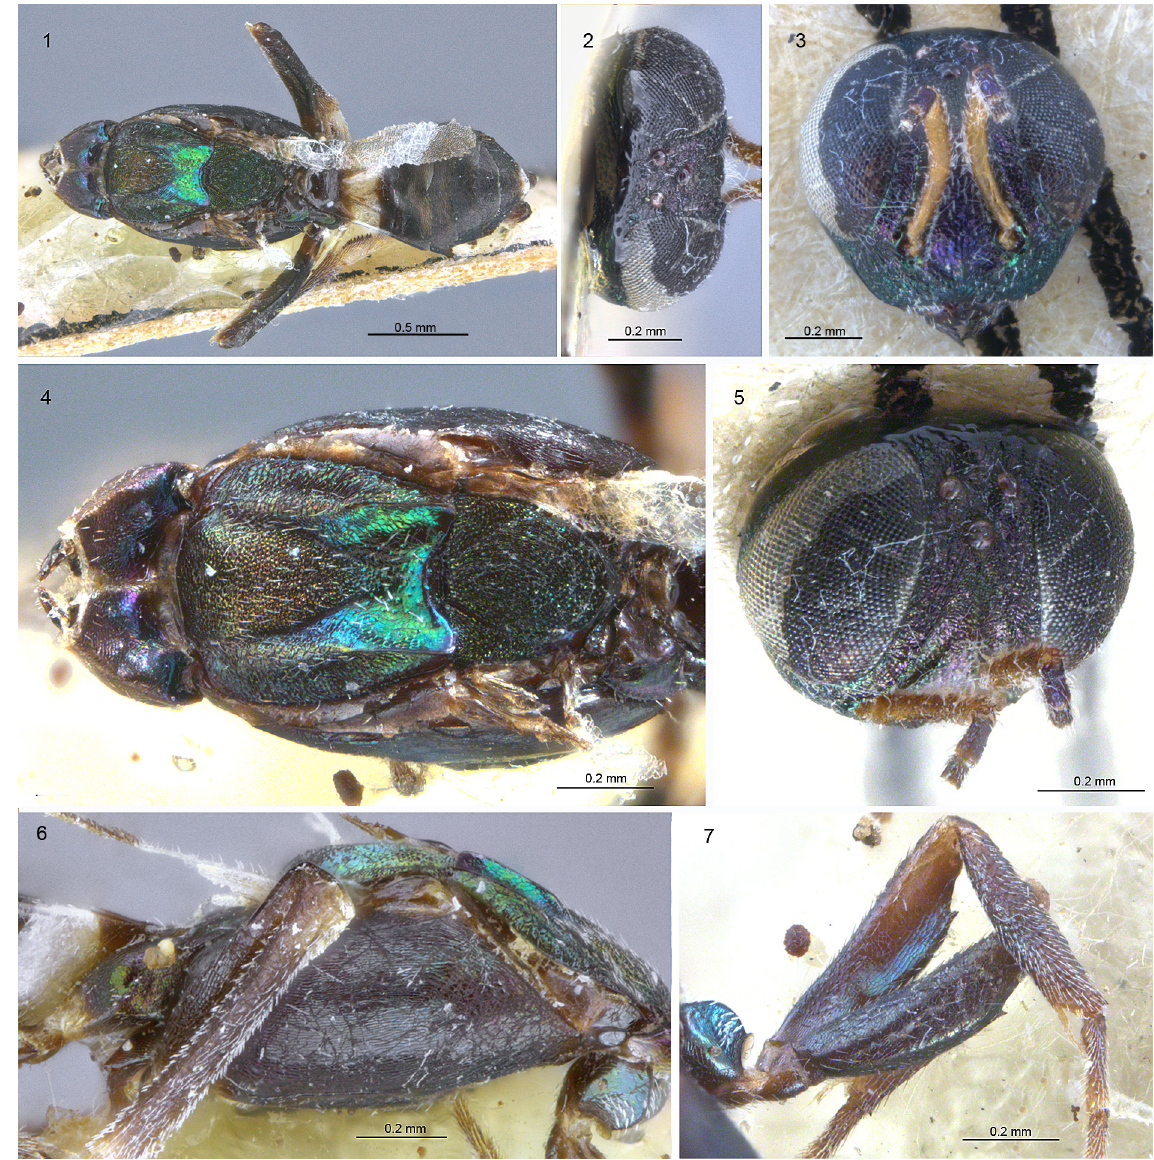
Figs 1–7. Anastatus dexingensis Sheng & Wang, 1997. 1–6 . Holotype, ♀. 1 . Body, dorsal view (wing mostly destroyed, remnants superficially appear like a short wing). 2 . Head, dorsal view. 3 . Head, frontal view. 4 . Mesosoma, dorsal view. 5 . Head, frontolateral view. 6 . Mesosoma, lateral view. – 7 . Paratype, ♀, front